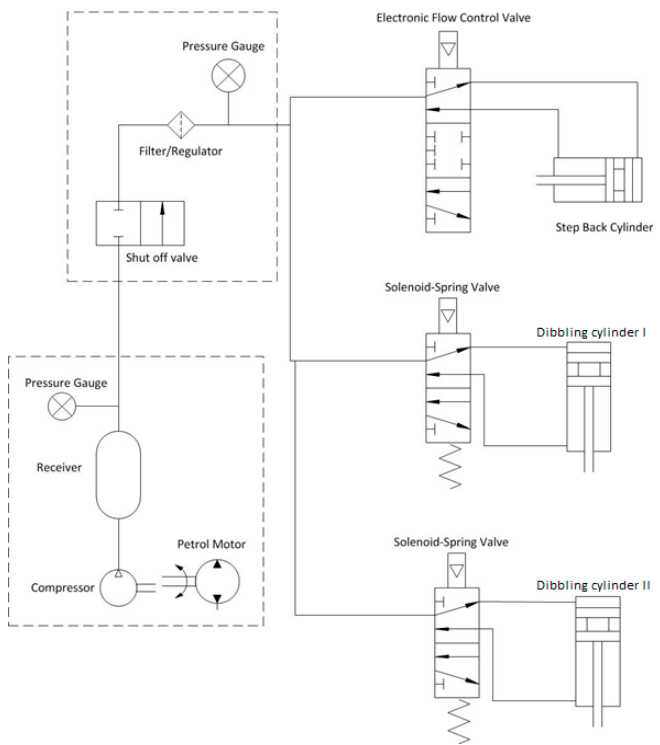
Figure 11. The pneumatic schematic of the dibbler.